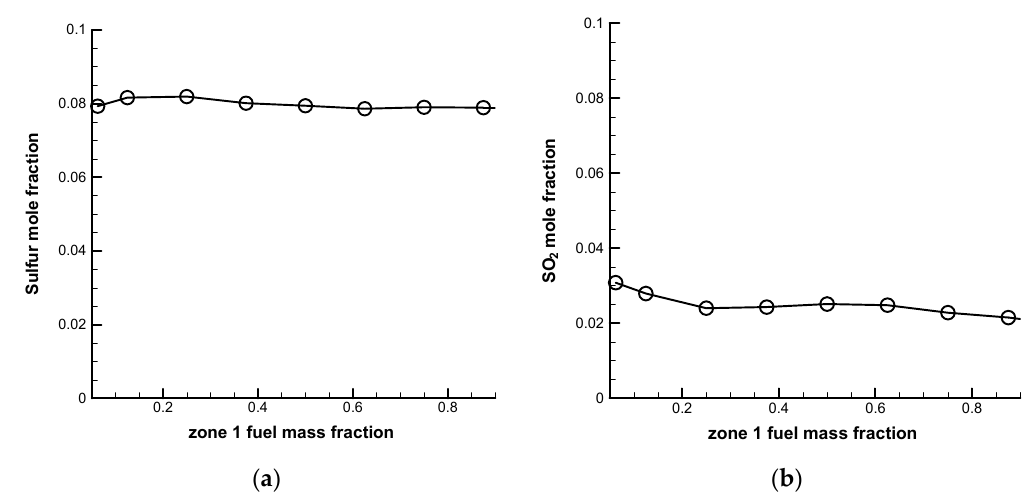
Figure 7. A comparison of the ( a ) sulfur and ( b ) sulfur dioxide concentrations at the exit for a SRU thermal reactor with different zone 1 fuel mass fractions.